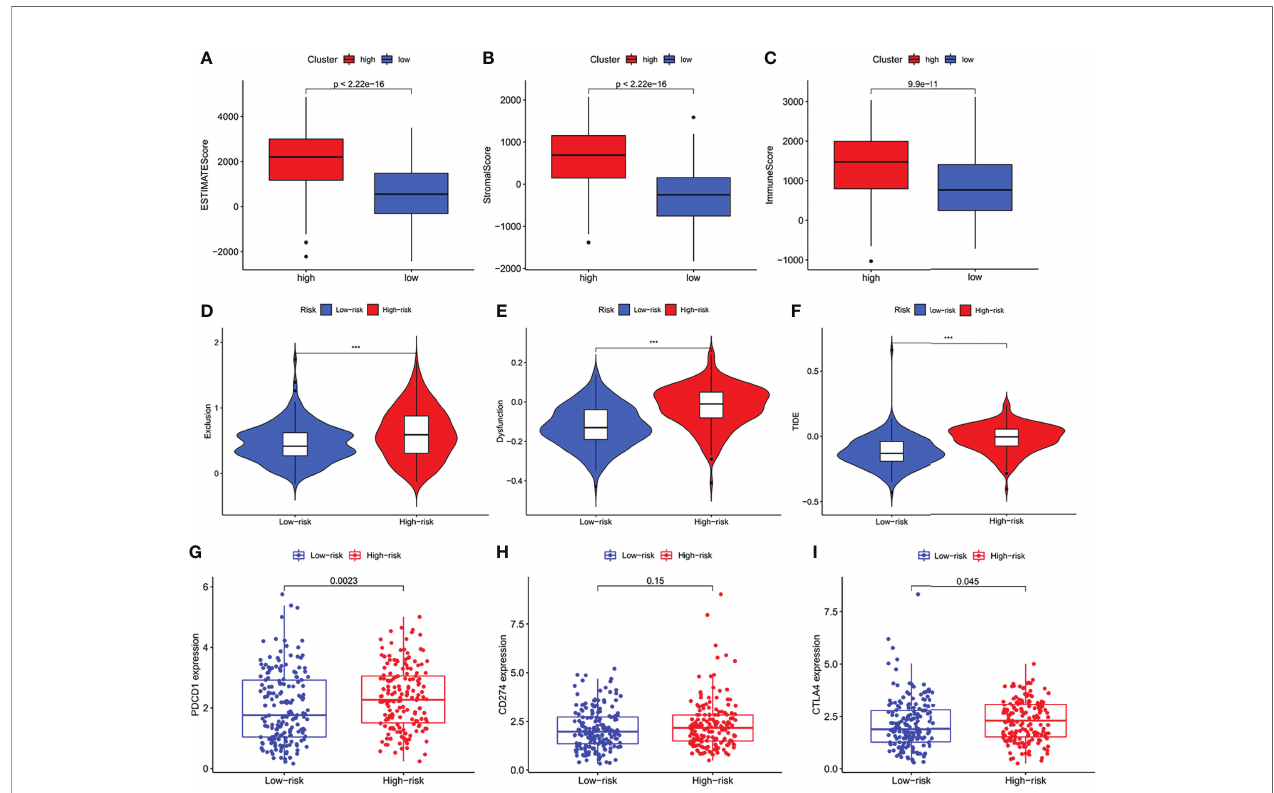
FIGURE 8 | The analysis of immune microenvironment, immune escape and immune checkpoint. (A – C) Comparison of ESTIMATE score, Stromal score and Immune Score between high-risk and low-risk subgroups. (D – F) Immune Escape. (D) Exclusion, (E) Dysfunction, and (F) TIDE score in different risk-groups. (G – I) Box plot showing correlation between IFRSig and immune checkpoint (PCDC1, CD274 and CTLA-4); ***p <